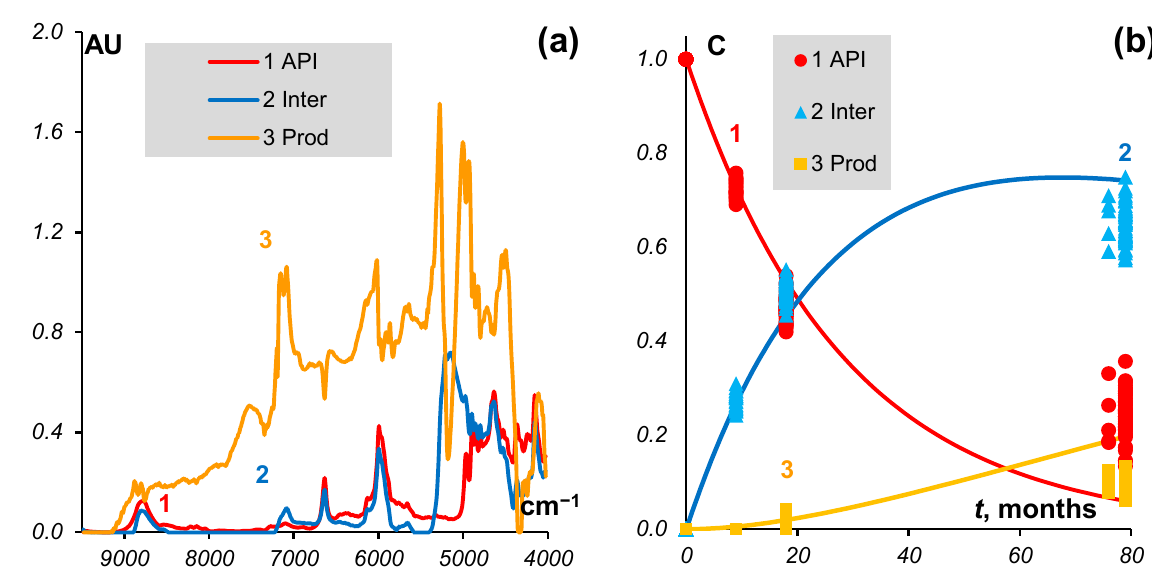
Figure 6. MCR model for tablets. ( a ) Spectra of API , Inter, and Prod ; ( b ) Concentrations (markers) and kinetics (curves).